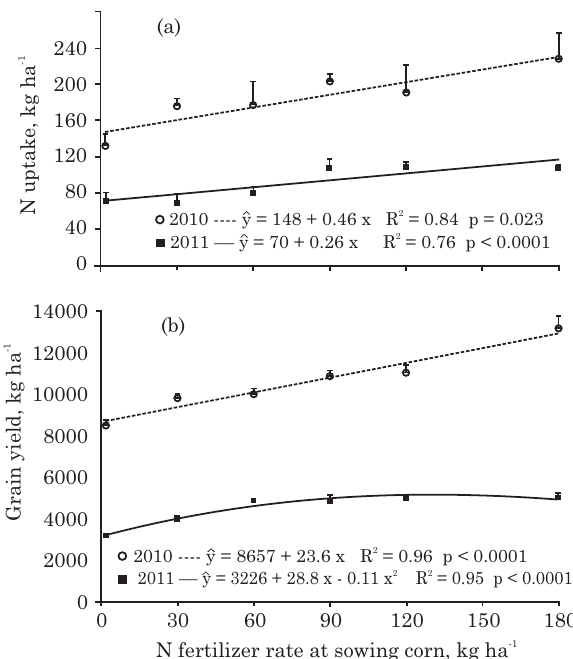
Figure 2. Nitrogen uptake (a) and corn grain yield (b) and affected by nitrogen fertilization rate in the 2010 and 2011 growing seasons. The mean values of the date are shown with error bars that shown the uncertaintly of the